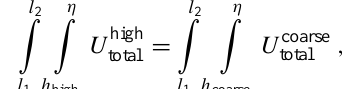
Fig. 3. (a) Monthly mean wind stress vector, and (b) monthly mean wind speed in the model domain. Data from the ECMWF re-analysis set from Jan. 1979-Dec.